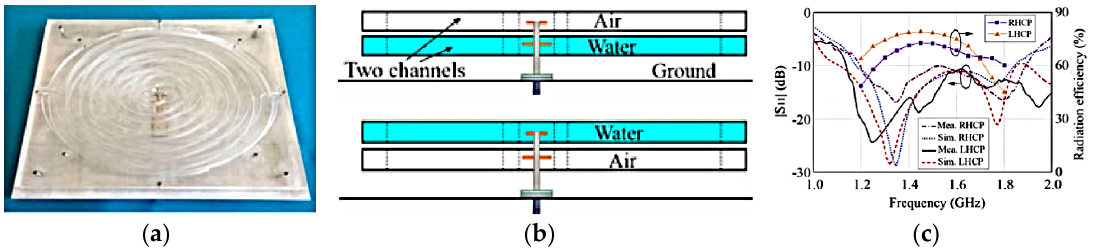
Figure 9. ( a ) Fabricated prototype, ( b ) different configurations and ( c ) measured/simulated results of the antenna (redrawn from [72]).